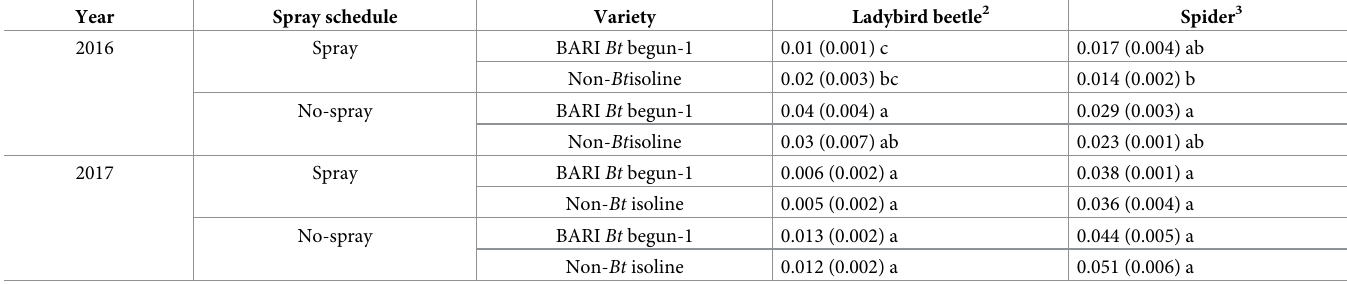
Table 9. Mean abundance 1 of non-target beneficial arthropods (No./leaf) in brinjal relative to insecticides and varieties, OFRD, BARI, Bogra,